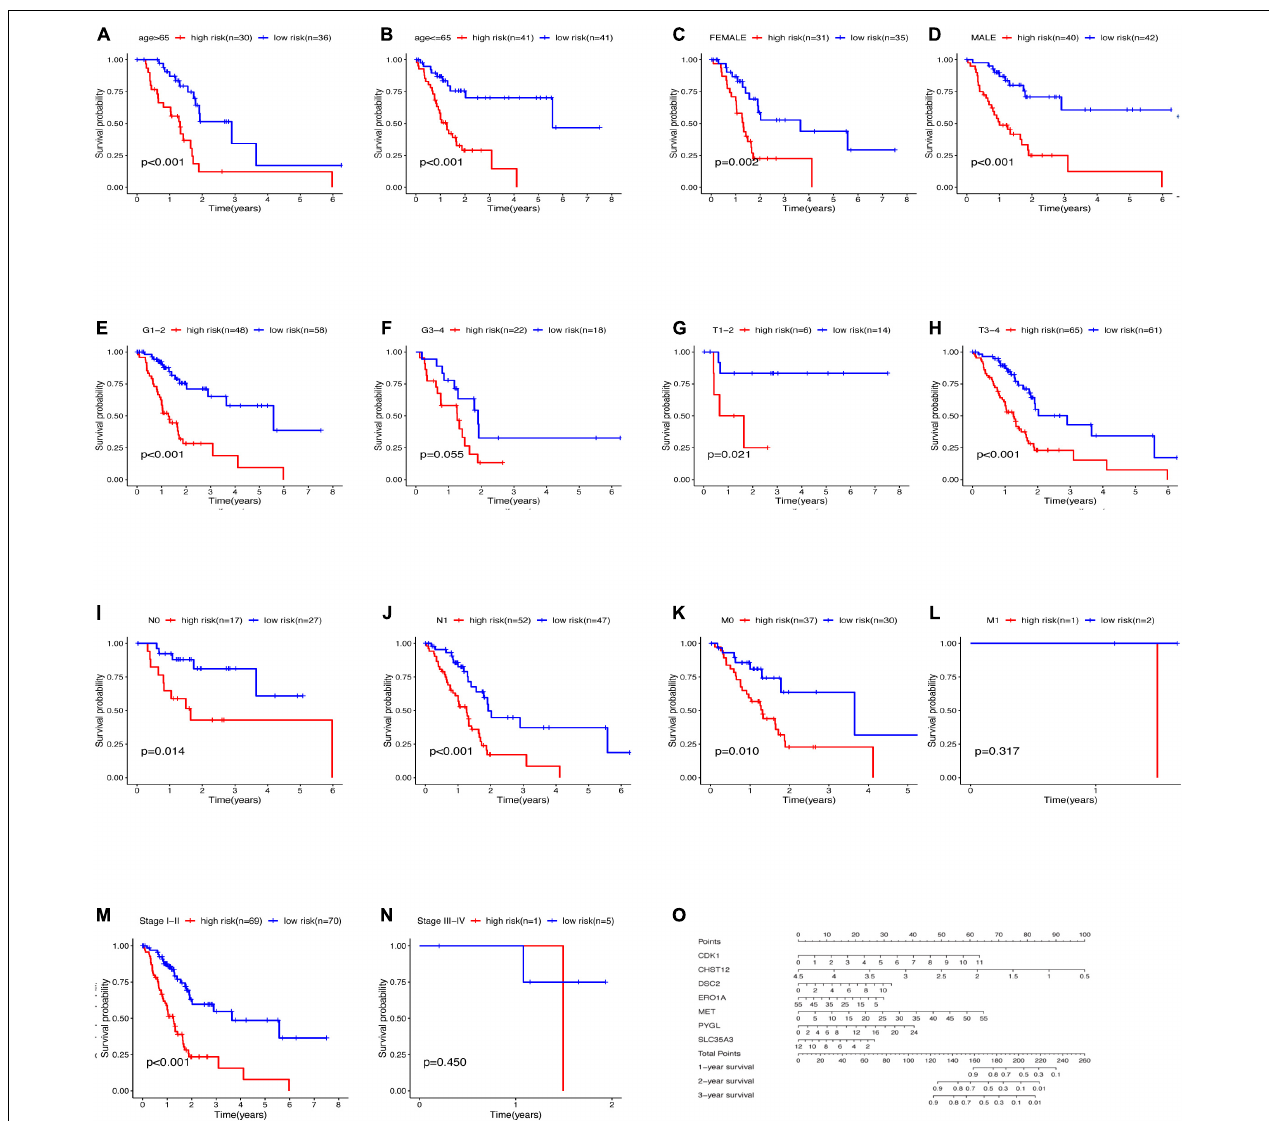
FIGURE 10 | Relationship between clinical features and survival of patients with pancreatic cancer after model grouping (A–N) . (O) Nomogram of the GRGs